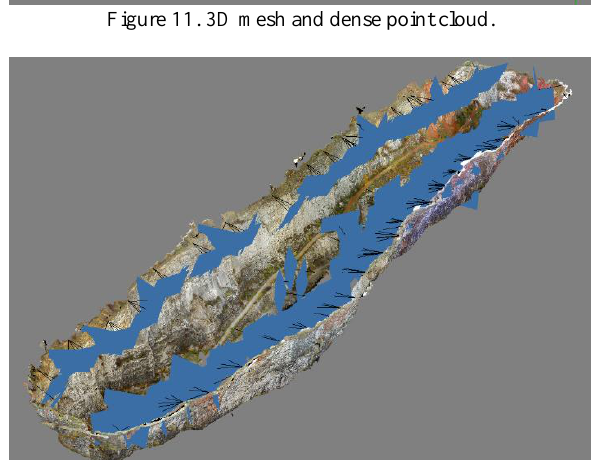
Figure 12. 3D textured model of quarry’s walls.